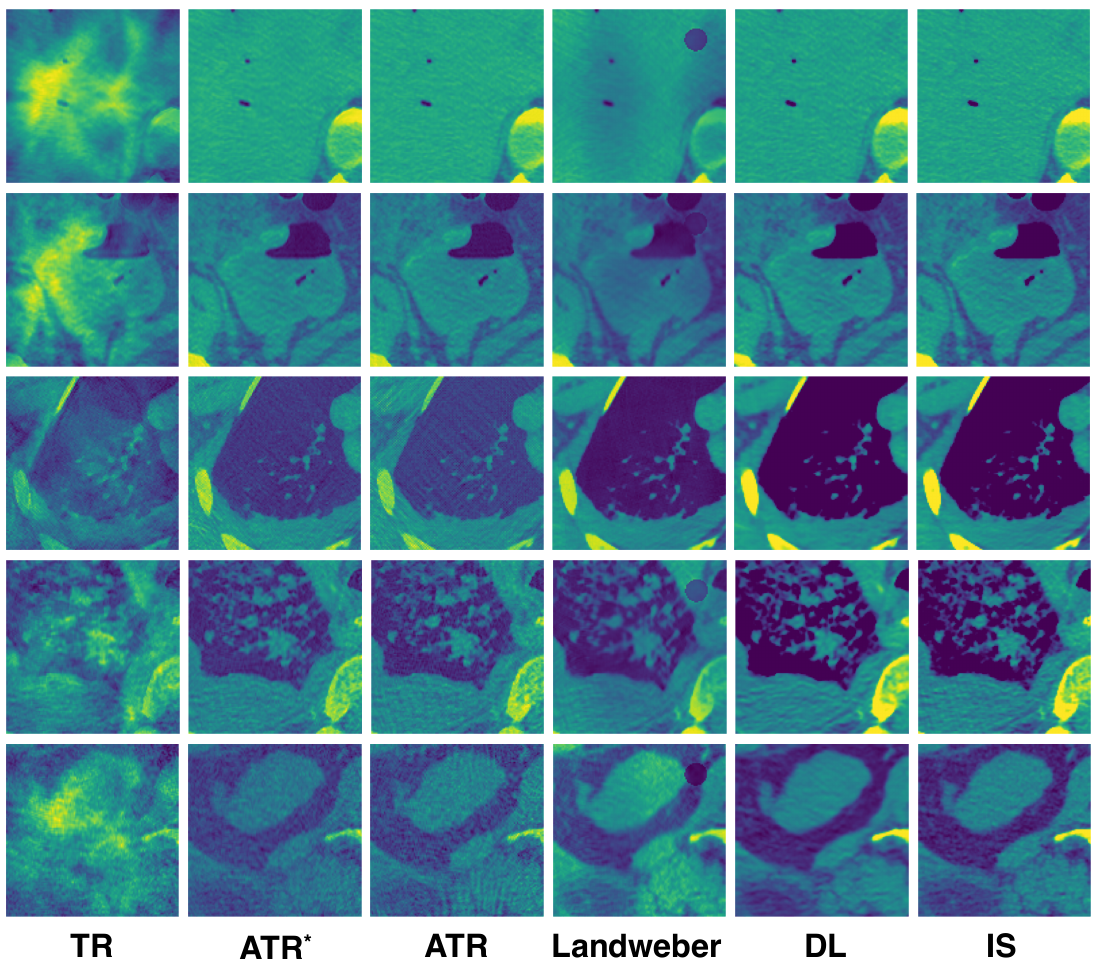
Figure 7. Reconstruction in a heterogeneous